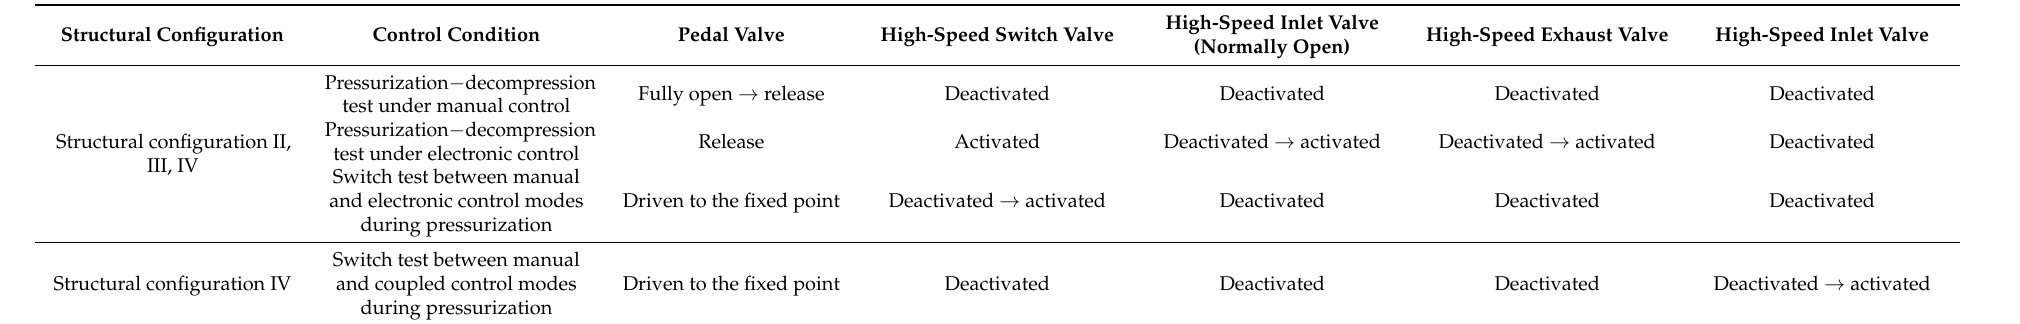
Table 3. Control conditions for the test of the pressure regulation characteristics of the APRV in structural configurations II, III and IV.